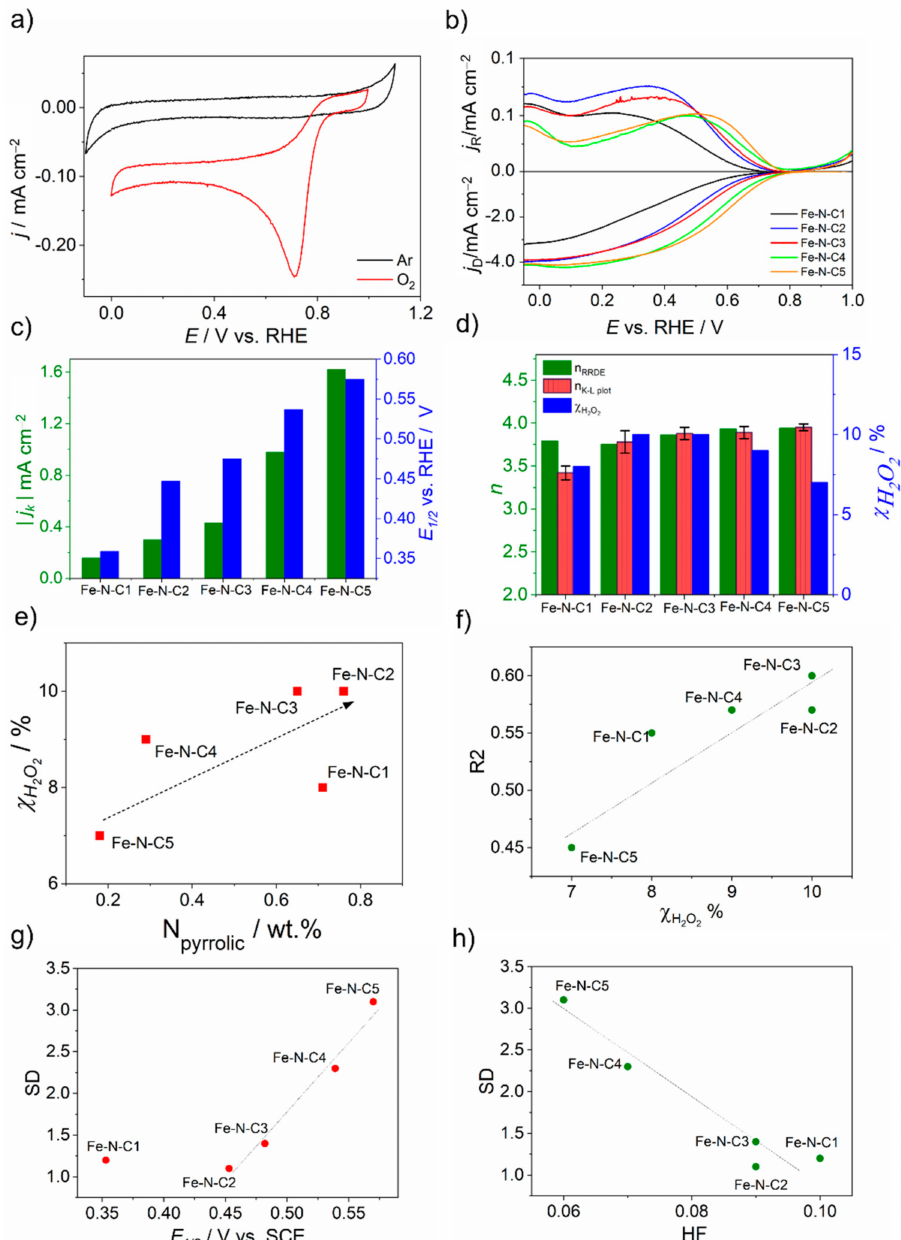
Figure 5. ( a ) Cyclic voltammetry of Fe-N-C5 recorded in Ar-purged and O 2 -saturated 0.5 M H 2 SO 4 , v = 2 mV s − 1 ; ( b ) LSV at RRDE recorded in O 2 -saturated 0.5 M H 2 SO 4 , v = 2 mV s − 1 and was ω = 1600 rpm; ( c ) Kinetic current and half wave potential for Fe-N-Cn; ( d ) Number of transferred electron for ORR and H 2 O 2 yield determined at 0.7 V RHE for all the investigated catalysts; ( e ) Cor- relation between the pyrrolic nitrogen species and H 2 O 2 percentage; ( f ) Correlation between the graphitization parameter R 2 calculated according to Equation (3) and H 2 O 2 percentage; ( g ) Cor- relation between the site density determined by nitrosyl stripping and the half wave potential; ( h ) Correlation between the site density and the hierarchical factor HF determined by Equation(1). In picture e–h, dotted lines are only intended for guiding the